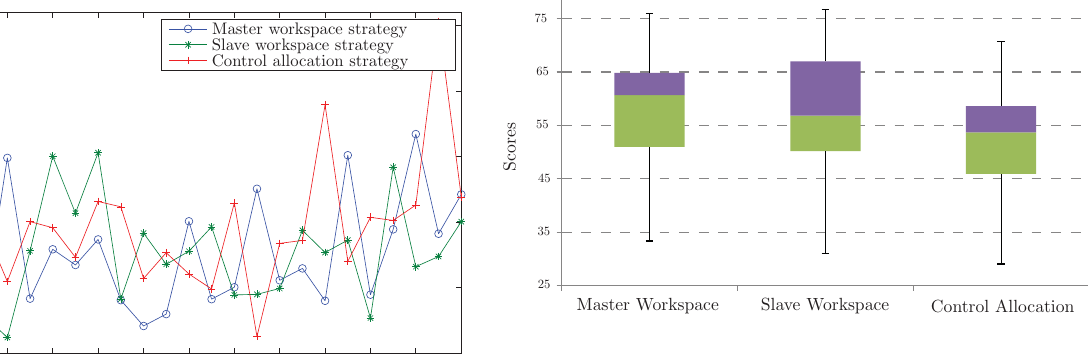
Figure 10: The median, the maximum, 75th percentile, 25th percentile and minimum values of NASA TLX scores.